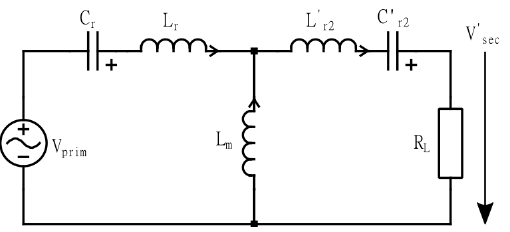
Figure 7. Simplified FHA model of CLLC in Forward